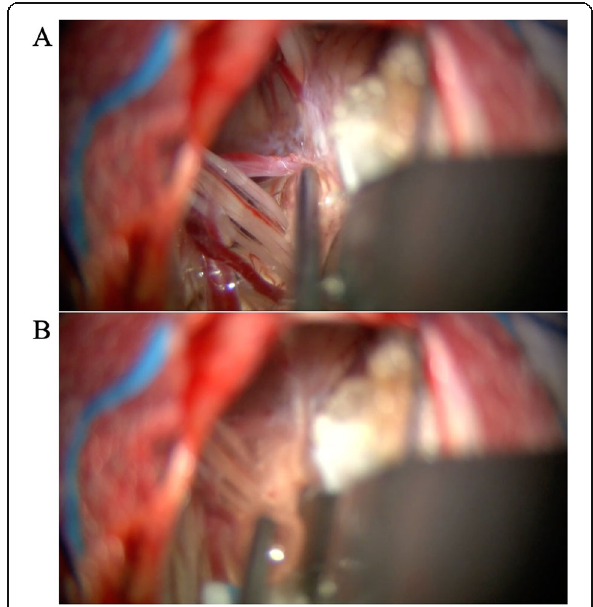
Fig. 2 Cerebrospinal fluid accumulation in the left cerebellopontine cistern during the surgery. a The photo before accumulation of cerebrospinal fluid. b After accumulation of cerebrospinal fluid. See the supplement video which is viewed